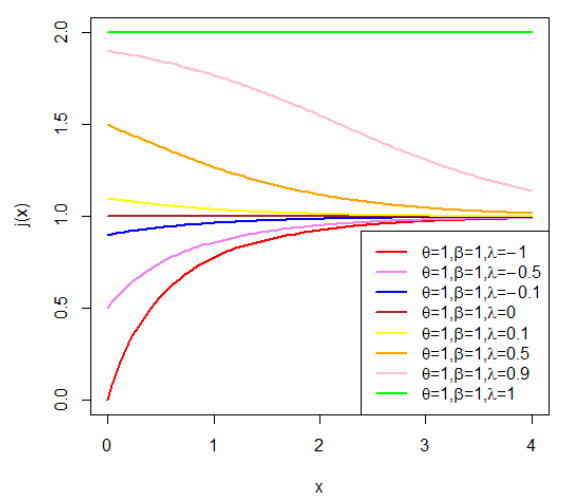
Figure 6 – Hazard rate function of ET E distribution for various parameter